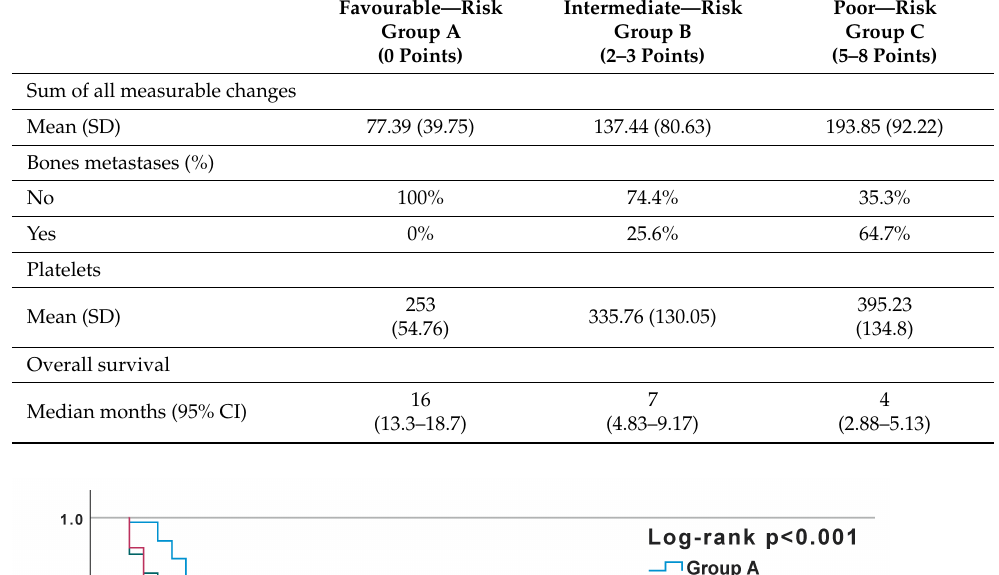
Table 8. Clinical characteristics of the prognostic groups.